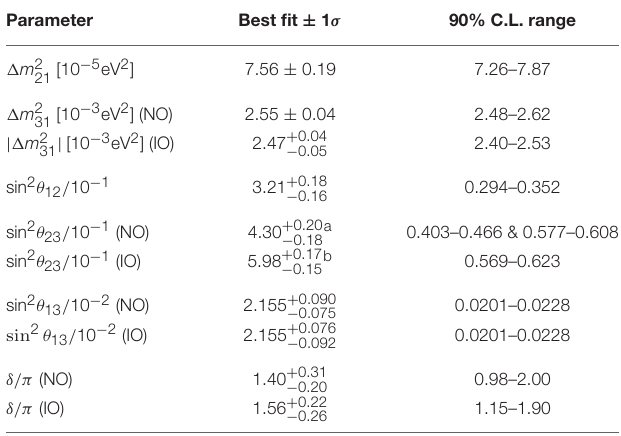
TABLE 1 | Neutrino oscillation parameters summary determined from the global analysis in de Salas et al. [39]. The ranges for inverted ordering refer to the local minimum of this neutrino mass